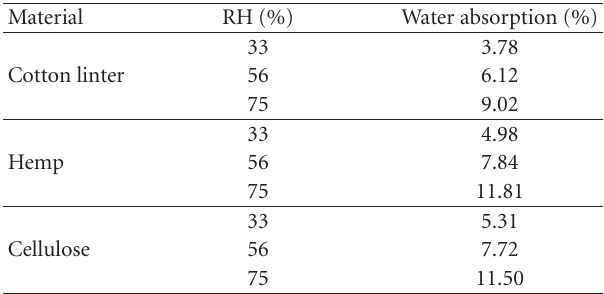
Table 8: Water absorption contents of natural fibres at various relative humidity ratios.